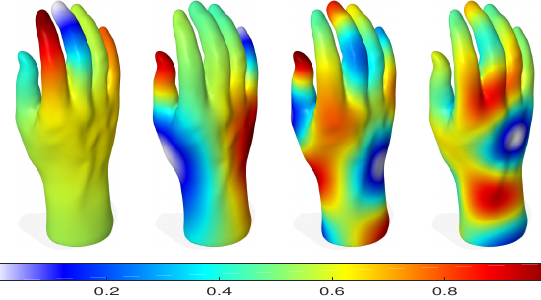
Figure 3. Visualization of four eigenvectors of the normalized mesh Laplacian matrix. From left to right : a 3D hand model Gouraud shaded and color-coded by the values of the second, eighth, fifteenth and twentieth